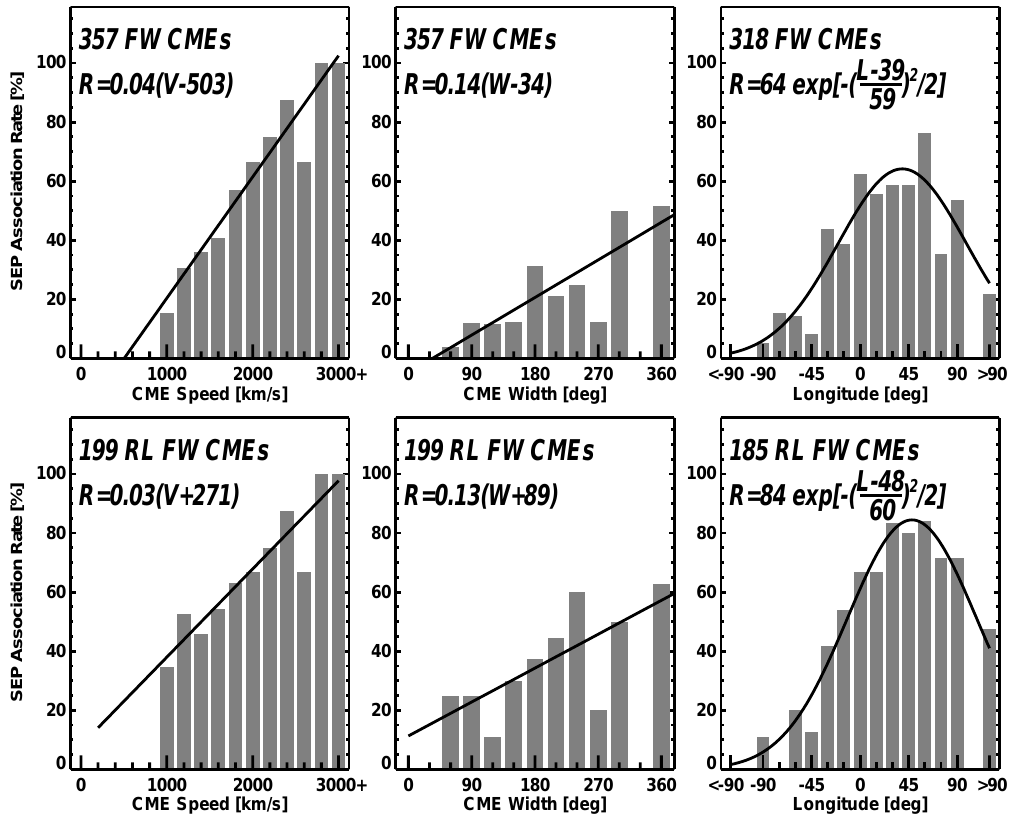
Fig. 9. SEP association rate of FW CMEs (top) and FW CMEs with type II bursts (RL FW CMEs, bottom) as a function of CME speed (V), width (W), and source longitude (L). All SEP events with intensity Ip ≥ 1pfu are included. Fitted curves to the distributions are shown on each plot.